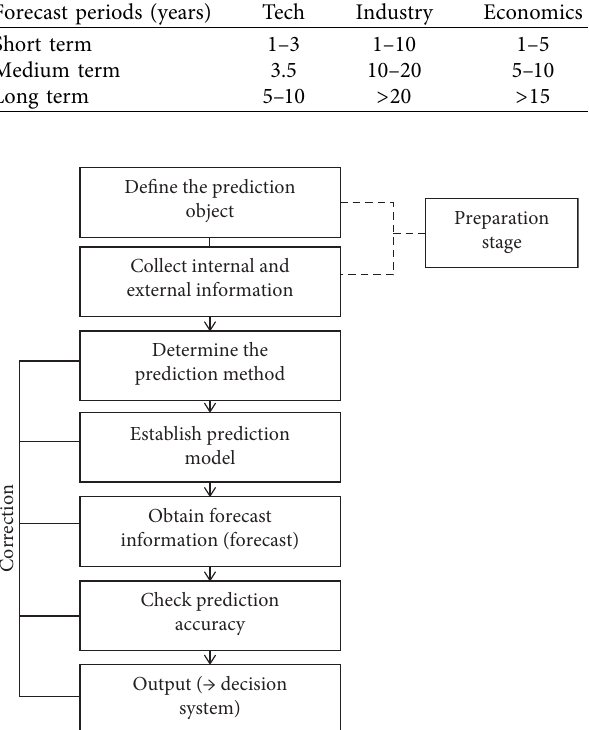
Figure 3: Typical process of marketing service in power supply